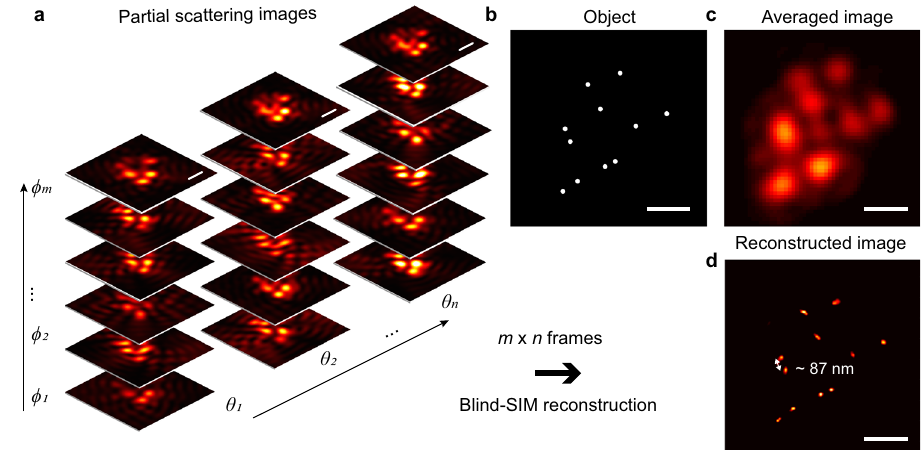
Fig.3|NumericalsimulationoftheHMESnanoscopy.a Partialscatteringimages of dielectric nanoparticles (radius r =40nm) with different oblique illumination angles, where the number of varied azimuthal angle of incidence m =12, the numberofvariedpolarangleofincidence n =10. b Thetestingobject. c Ascattering